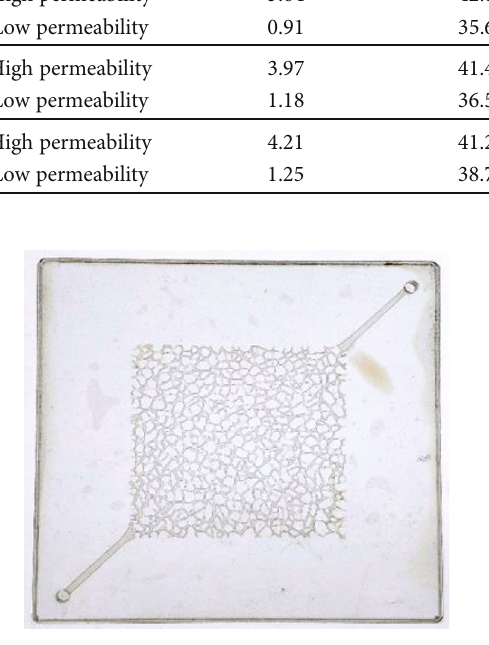
Figure 2: The appearance of 2D glass-etched